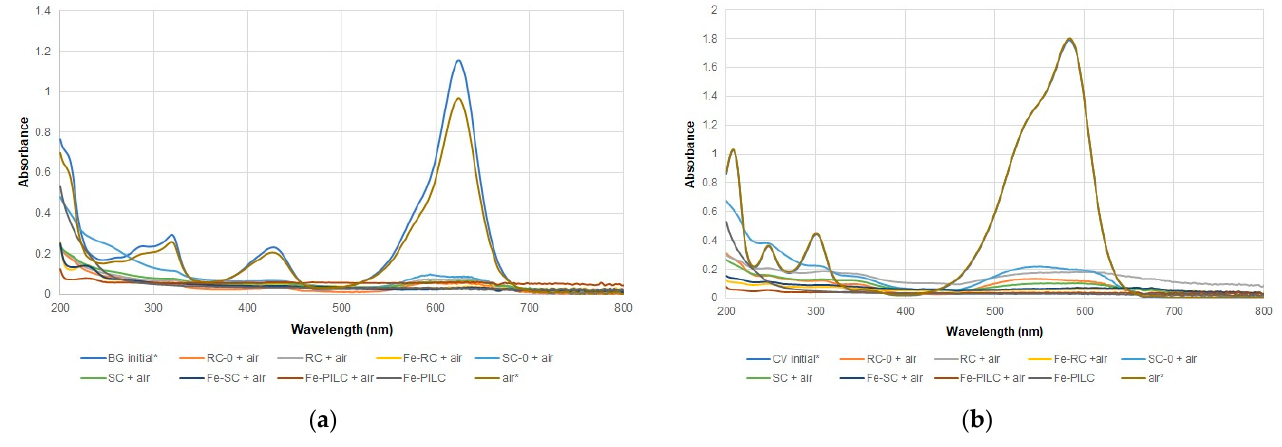
Figure 5. Absorption UV-Vis spectra changes at the end of CWAO process for BG ( a ) and CV ( b )—100 mg/L initial concentration (* indicates a dilution coefficient of 10).